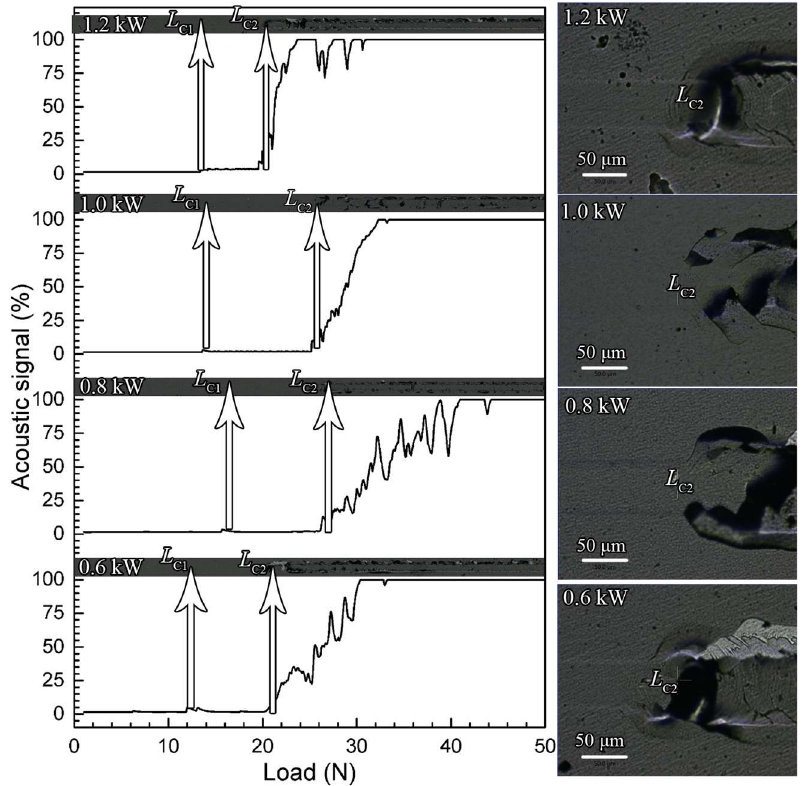
Figure 8. Acoustic signal versus load curves and scratch images of the four CrAlSiN coatings deposited under different Al sputtering power.